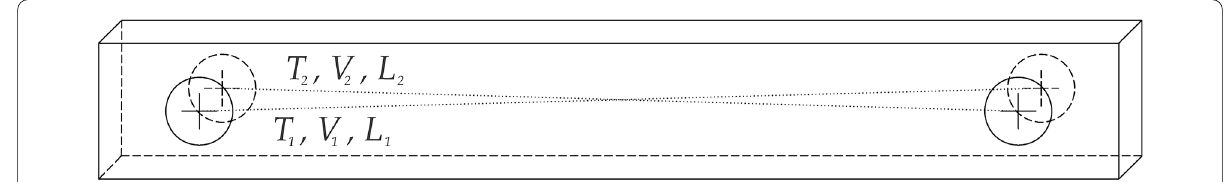
Fig. 9 Scheme of determination of length of measuring basis ( L 1 , L 2 ), time ( T 1 , T 2 ) and velocity ( V 1 , V 2 ) of passage of ultrasonic pulses through the test